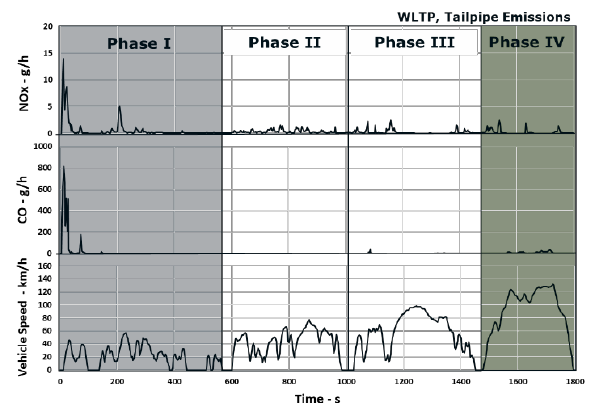
Fig. 4. Pollutant emission of an EU6dtemp vehicle with Gasoline engine in the WLTP With the Gasoline engine, a strong concentration of pol- lutant emissions on the non-warmed up or highly dynamic engine operation is obvious. These relations are not only valid for this single vehicle, but are also confirmed on a broad statistical basis, Fig. 5.